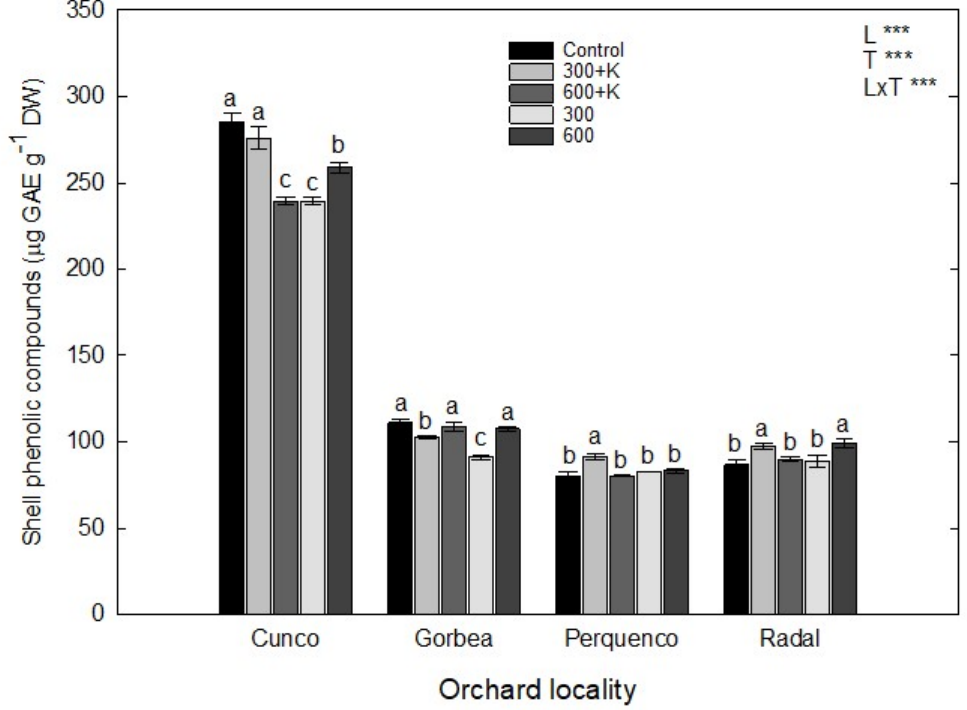
Figure 3. Phenolic compounds ( µ g GAE g − 1 DW) in the shells of TDG hazelnuts after the foliar spraying of Ca, Mg and K in four orchards in the La Araucan í a region. Bars represent the average of four replicates ± S.E. Different letters indicate statistical differences ( p ≤ 0.05) between treatments in the same locality. Two-way ANOVA results are shown; *** p < 0.001. Control (water), 300+K (Ca+Mg+K at 300 mg L − 1 ), 600+K (Ca+Mg+K at 600 mg L − 1 ), 300 (Ca+Mg at 300 mg L − 1 ), and 600+K (Ca+Mg at 600 mg L − 1